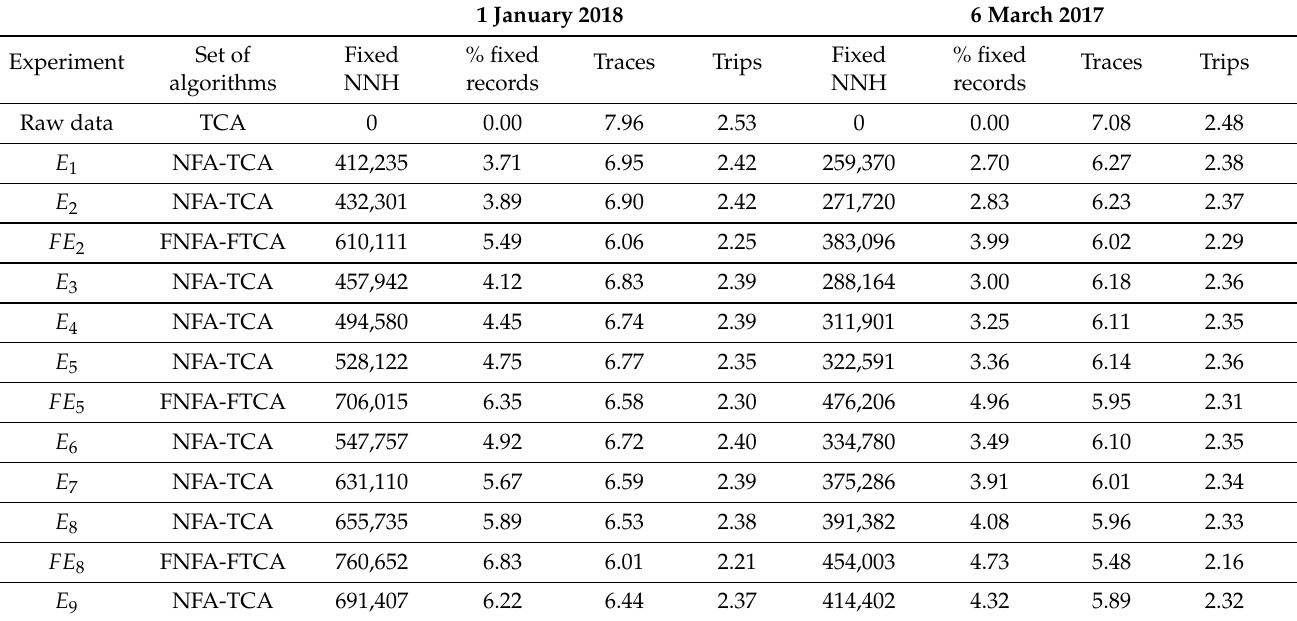
Table 7. Some results of experiments from previous and current work. Compared data for Greater